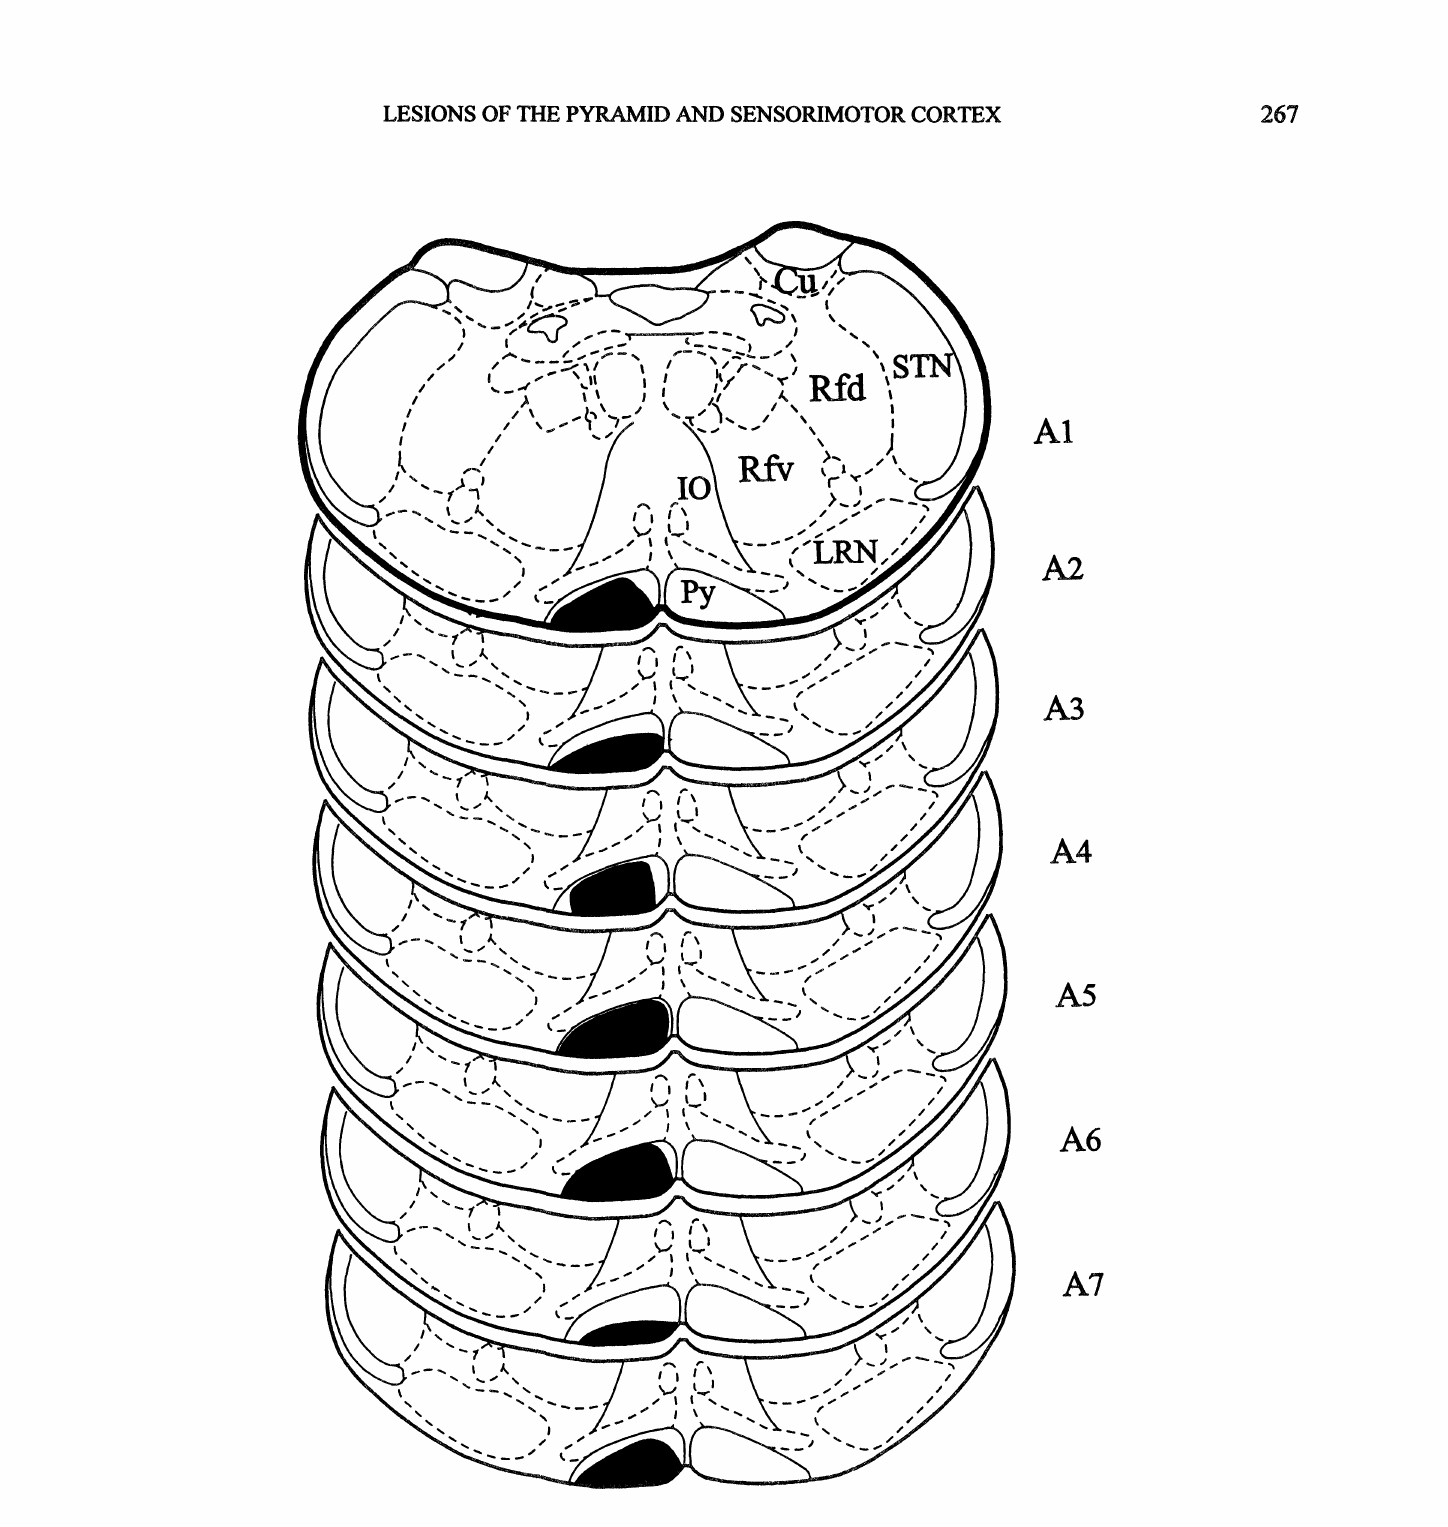
Extent of pyramidal lesions in rats. The lesions are redrawn by solid color on frontal section at 13.68 mm caudal from bregma (Paxinos & Watson, 1986). The right side is being shown on the right. Letter and numerals indicate rat series and number. Cu-cuneate nucleus; IO-inferior olive; LRN -lateral reticular nucleus; Py- pyramidal tract; Rfd-medullary reticular field, dorsal; Rfv-medullary reticular field, ventral; STN-spinal trigeminal